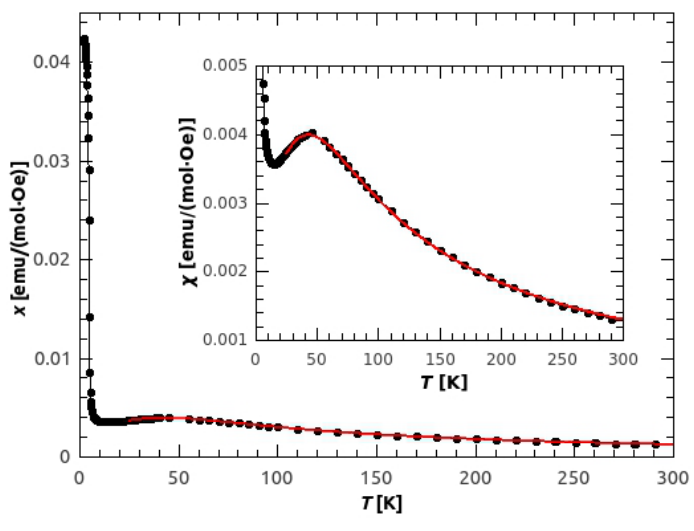
Figure 3. Temperature dependence of molar susceptibility of the powder sample of GuaCuF, mea- sured in 1 kOe. Red line represents the Bonner-Fisher spin-chain fit with mean field correction for the inter-chain